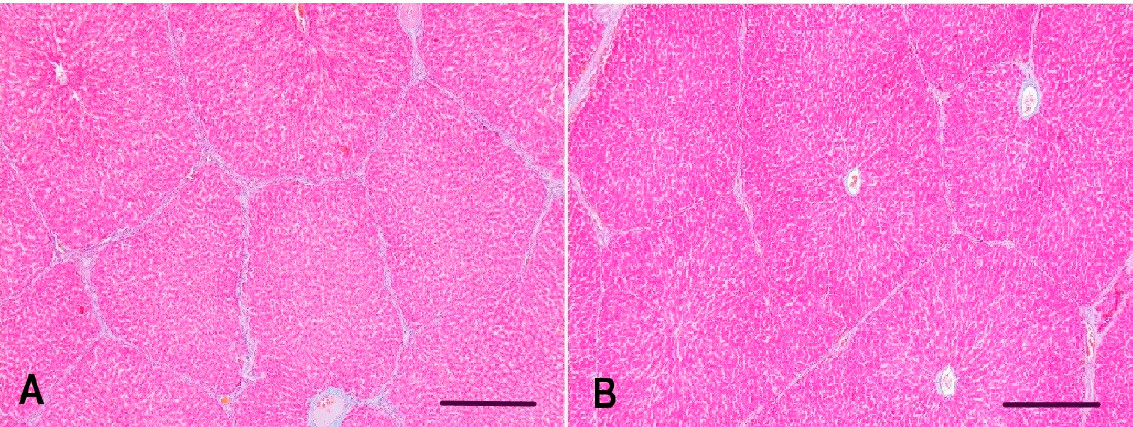
Figure 3. Representative microphotographs of hepatic lobules and surrounding interlobular connective tissue of gilts: ( A ) gilt from the control group with an expected amount of interlobular connective tissue and ( B ) gilt from the experimental group with a decreased amount of interlobular connective tissue in comparison with the control group. Goldner’s Masson trichrome stain, bar = 100 µm.